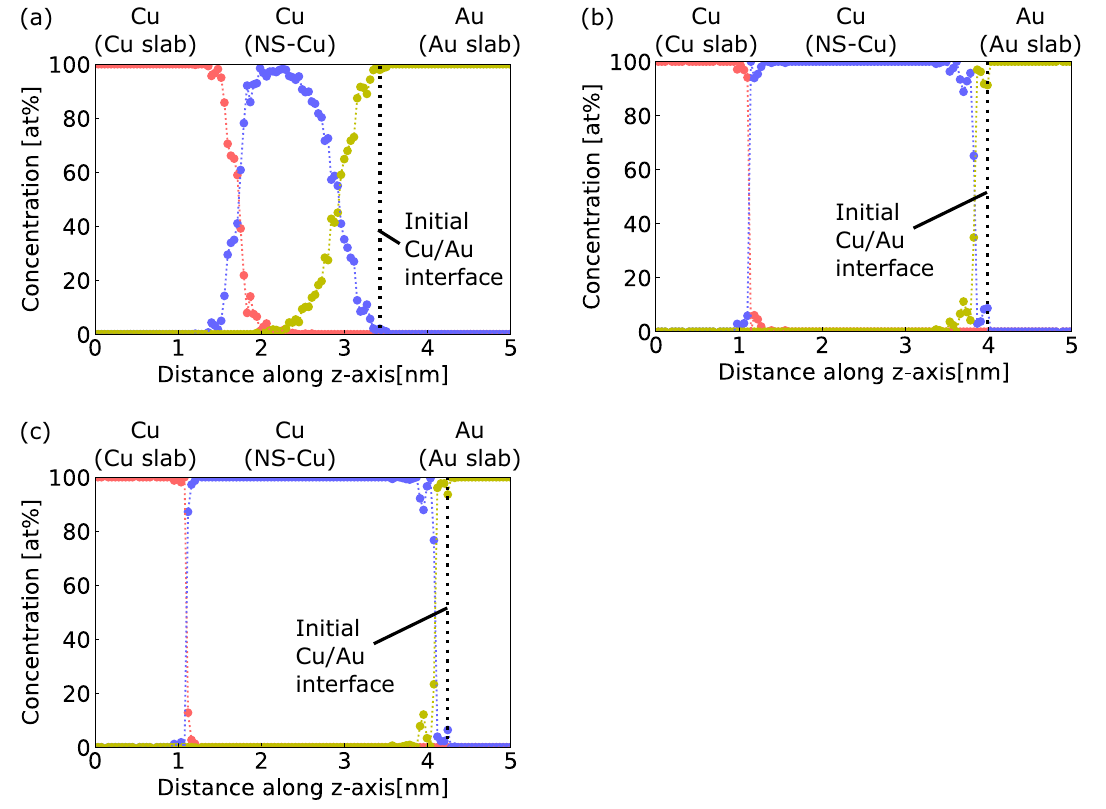
Figure 3. Concentration of Cu and Au atoms along the z-axis at a time step of 1005 ps and S v = ( a ) 2.8, ( b ) 2.2, and ( c ) 1.6 nm −1 . Red plots and line represent the Cu slab; blue plots and line represent NS-Cu; yellow plots and line represent the Au slab (only concentrations near the interface are